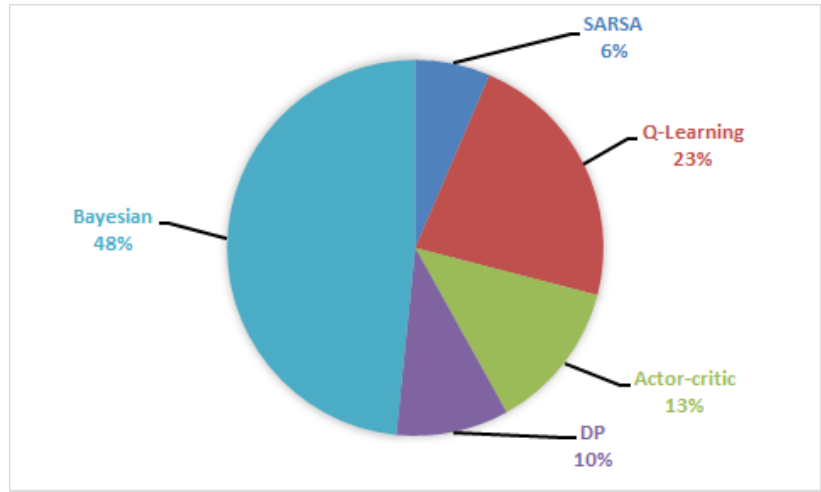
Figure 7. Percentage of papers surveyed by RL algorithm.